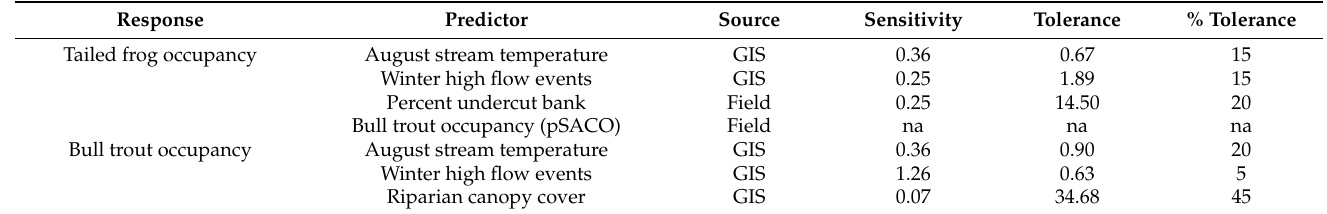
Table 2. Top predictor variables in occupancy models for Rocky Mountain tailed frogs and bull trout in 96 sites where both field-measured and GIS-derived predictors were collected. We also report the source, model Sensitivity (relative importance), Tolerance (niche breadth), and % Tolerance (percent of the variable’s range) for each selected variable. Na indicates test statistics that could not be calculated because the predictor variable was binary.